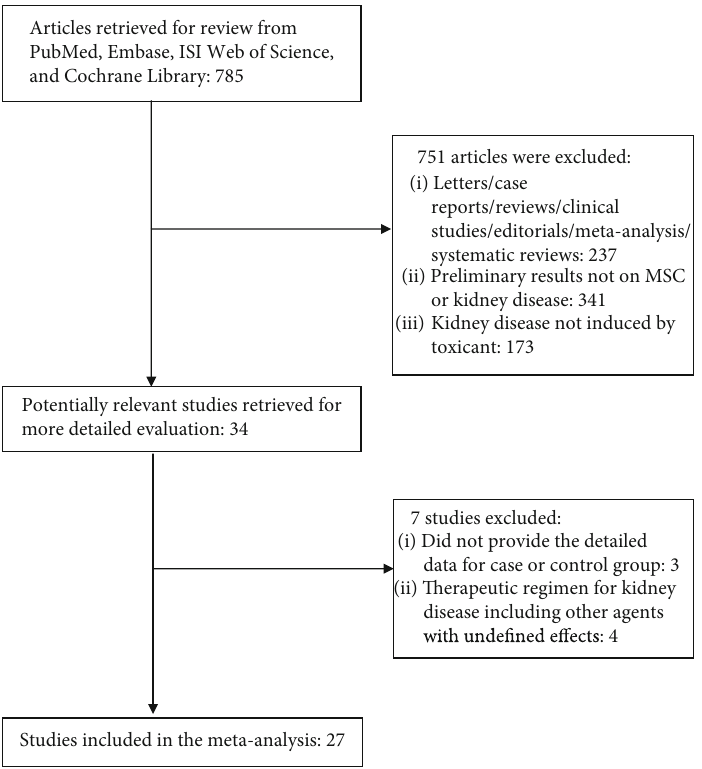
Figure 1: Flow diagram of the selection